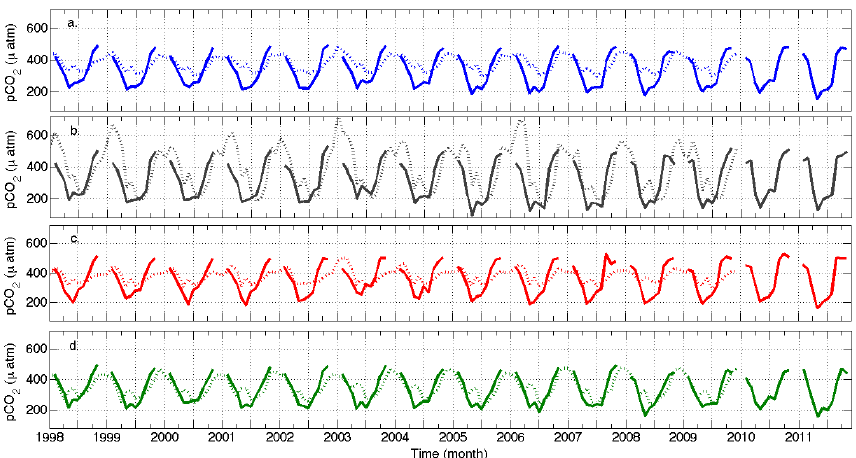
Figure 14. Comparison between modelled p CO 2 (dotted lines) and p CO 2 estimated using the SOM linear method (solid lines) for (a) the Baltic Sea (BS, blue), (b) the Gulf of Finland (GF, grey), (c) the Gulf of Bothnia (BG, red), and (d) the central basin (C, green).